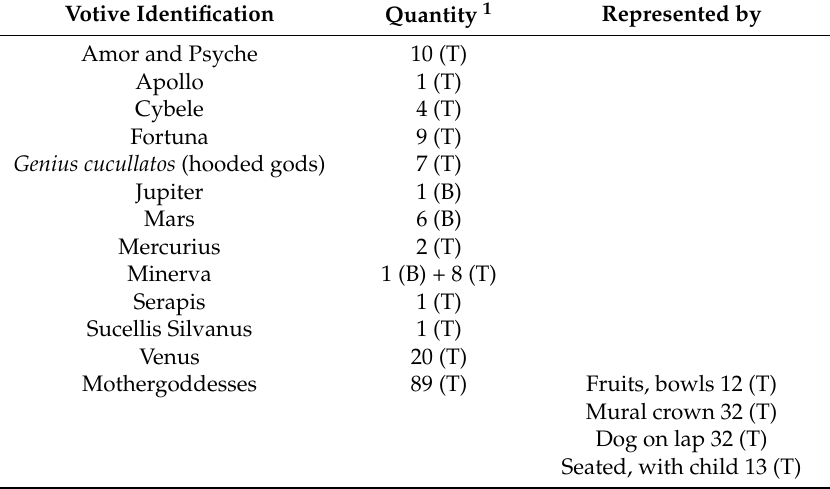
Mural crown 32 (T) Dog on lap 32 (T) Seated, with child 13